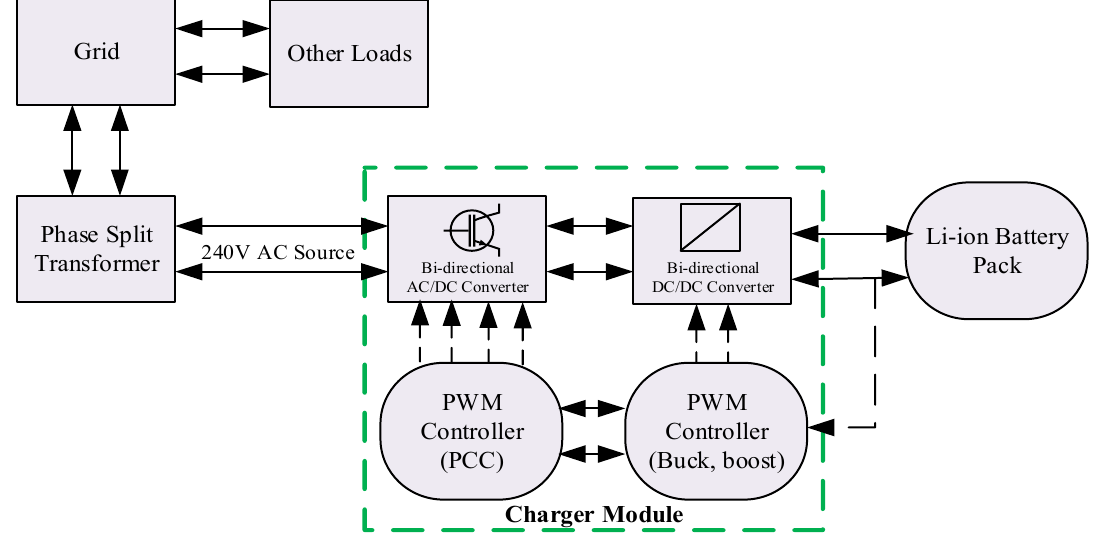
Energies 2019 , 12 , x Figure 6. Generalized energy flow diagram for V2G and V2H system [52]. PWM: pulse width modulation. Figure 6. Generalized energy flow diagram for V2G and V2H system [52] . PWM: pulse width modulation.